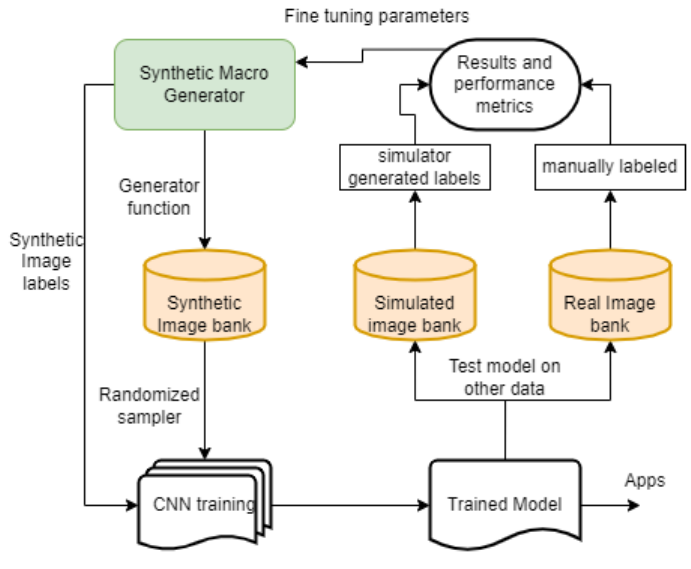
Figure 2. CNN training method.